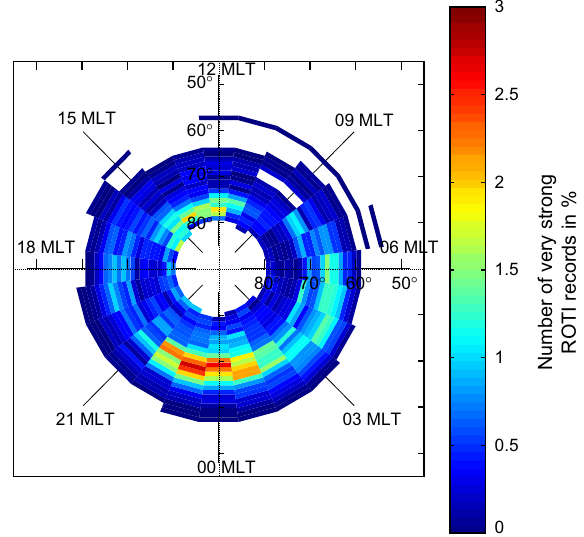
Fig. 10. Number of ROTI (cid:4) 5 TECU/min in percent, with an elevation cutoff of 30 (cid:2) . Note that the color scale is different from the color scale in Figure 9.